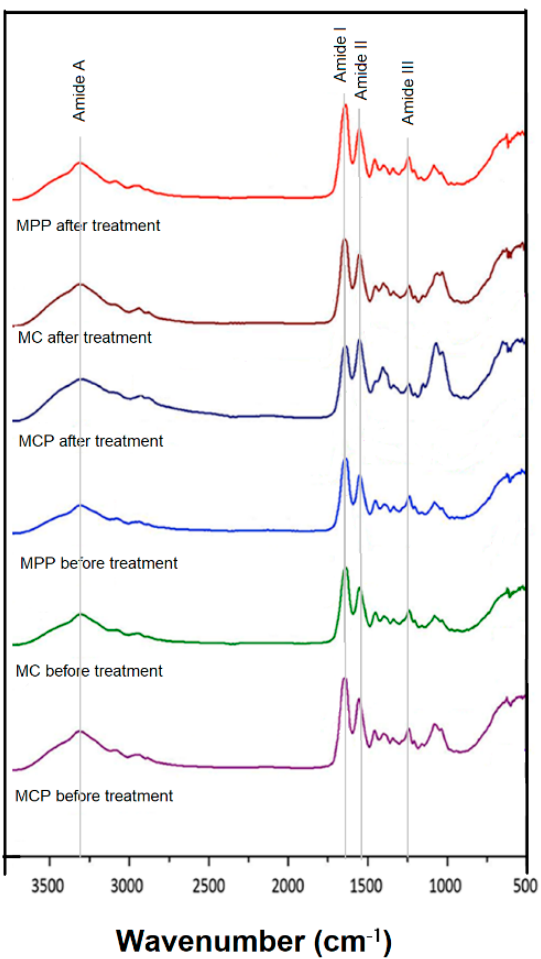
Figure 2. ATR FTIR (Attenuated Total Reflection Fourier Transform Infrared) spectra of commercial collagen membranes for bone-guided regeneration before and after PRGF treatment. Legend: Biocollagen ® = MCP; Cova TM Max = MPP; Jason ® = MC.